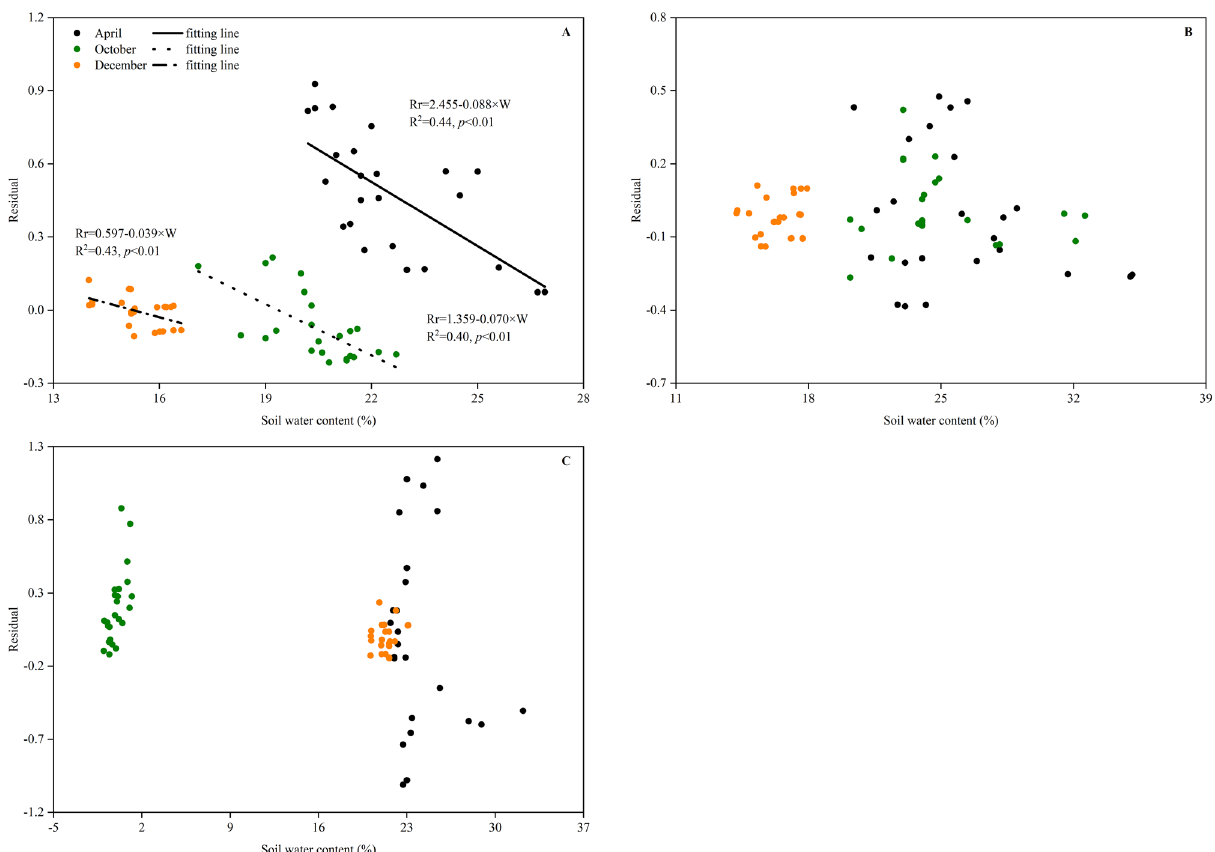
Figure 7. Relationships of daytime soil respiration residual in April, October and December with soil water contents at the CK (A) , CT (B) and WM (C) sites. Different types of lines are the linear fits for different months. The residual values of observed soil respiration and modeled values from the Q 10 function were related to soil water content at 10 cm. CK, natural coastal wetland; CT, cotton mono-cropping farmland; and WM, wheat– maize rotation cropping